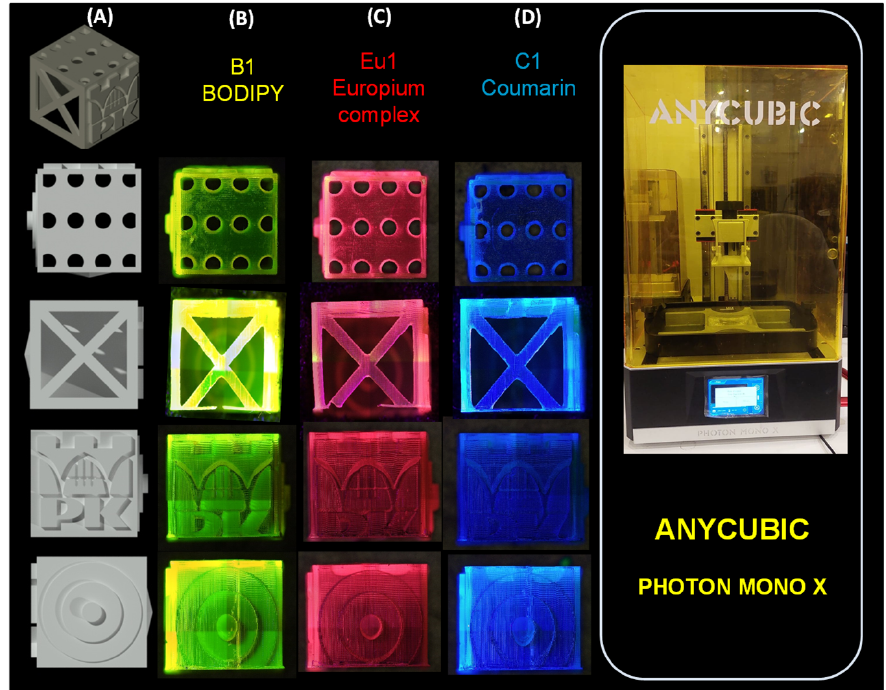
Figure 5. ( A ) Three-dimensional cube model made in AutoCAD 2020; print comparison obtained by Photon Mono X printer. Comparison was made with light on (366 nm) for: ( B ) B1; ( C ) Eu1; and ( D ) C1. Three-dimensional objects were observed using the OLYMPUS DSX1000 optical microscope.